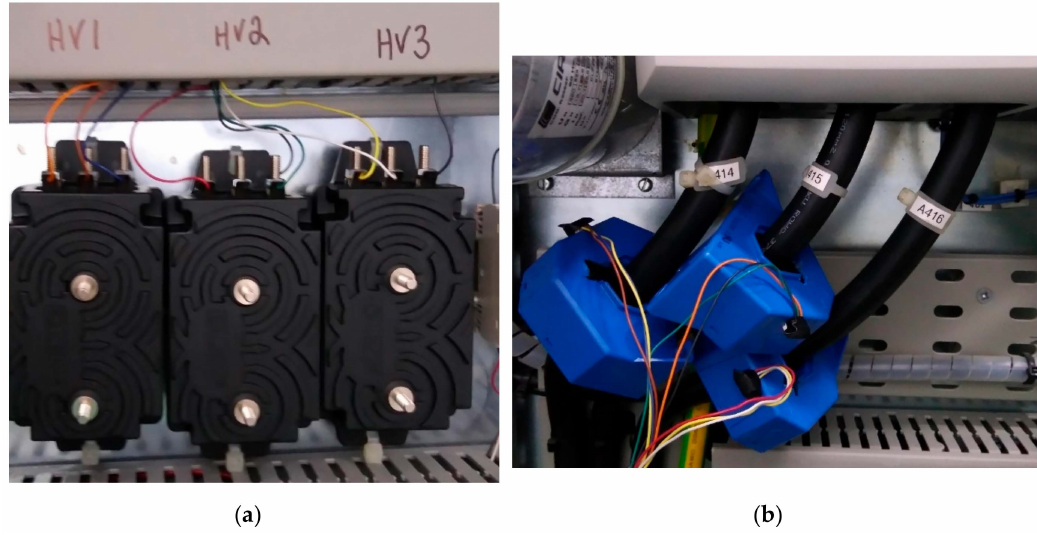
Figure 2. The voltage and current transducers installed in the Mutriku Wave Power Plant: ( a ) three LEM DVL 750 voltage transducers; ( b ) three LEM LA 305-S current